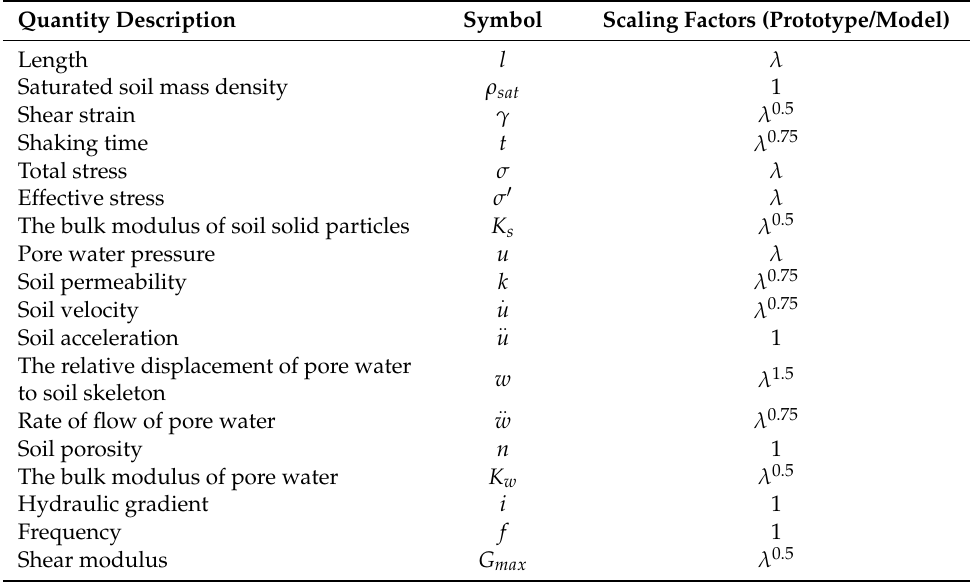
Figure 10. Excess PWP during the third shaking cycle. Table 3. Summarized applicable similitude laws for shaking table as per